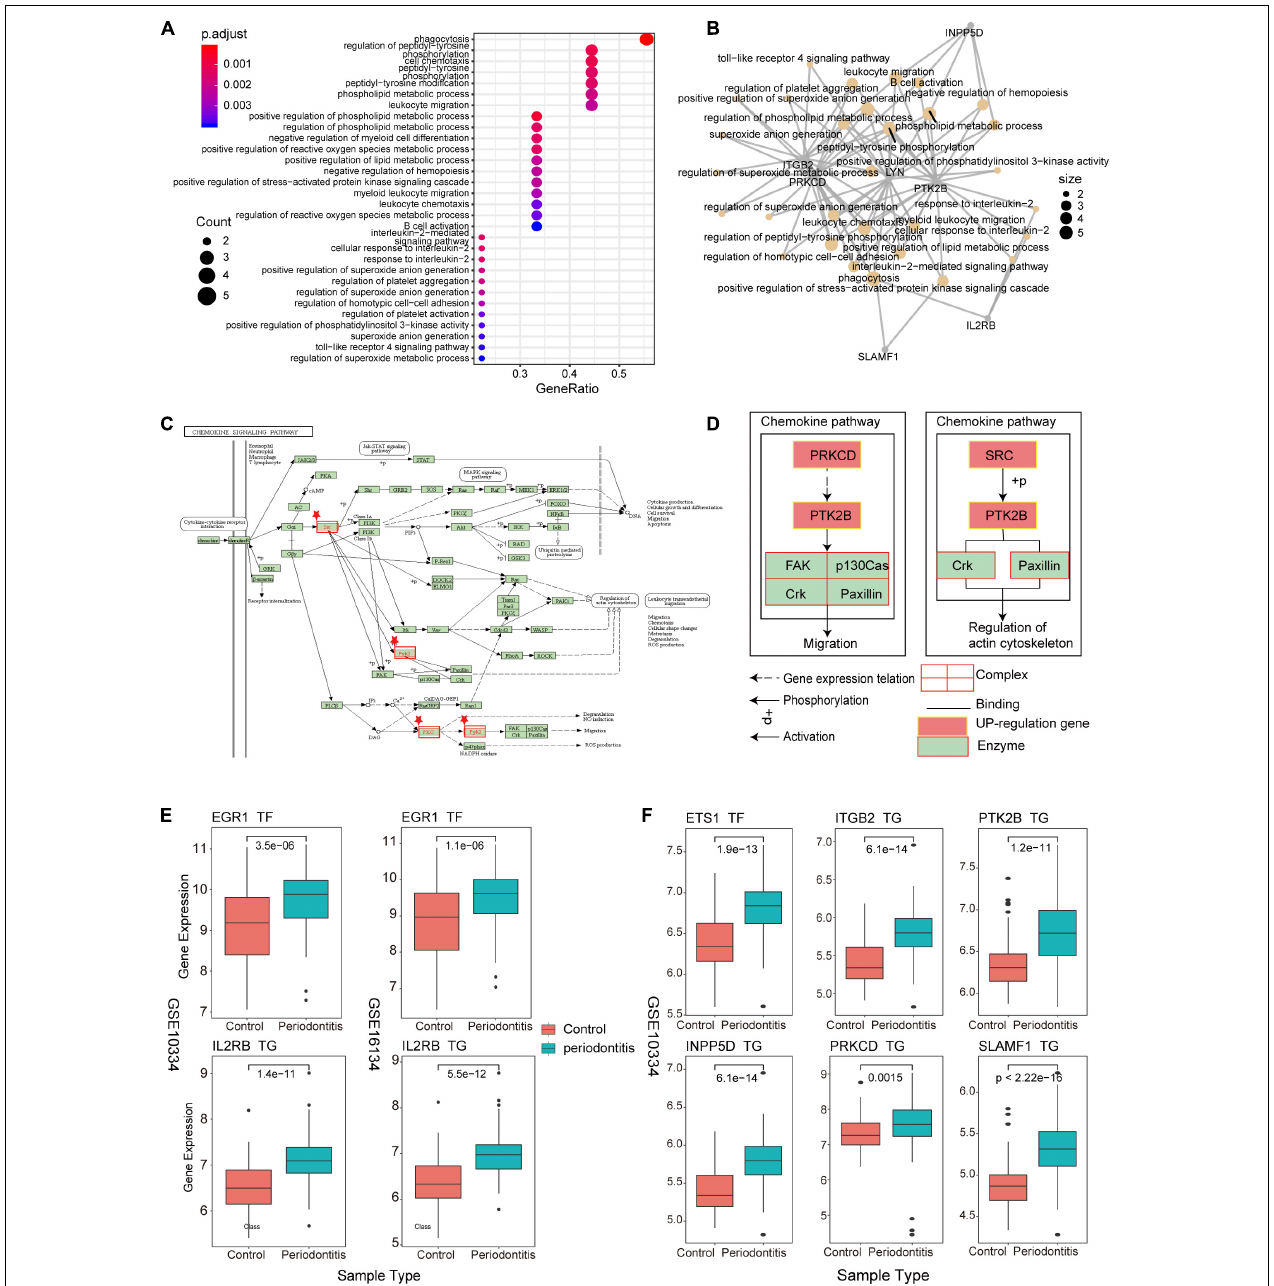
FIGURE 5 | New-module function and pathway analysis (A) . The dotplot of enriched biological pathways (BP) across up-regulated genes in the New-module. GeneRatio is the number of enriched genes/number of all genes of a GO term. (B) Network of enriched terms, where nodes that share the same genes are typically link to each other. The size of the dot represents the counts of gene. (C) The pathway diagram is one of the functional pathways enriched by up-regulated genes in the New-module gene. (D) The mechanism of the New-module up-regulated genes on the chemokine signaling pathway. (E) The boxplot represents the transcriptional regulatory relationship of the up-regulated genes in the New-module for GSE10334 and GSE16134 series. (F) The same as in (E) but only for GSE10334 series.